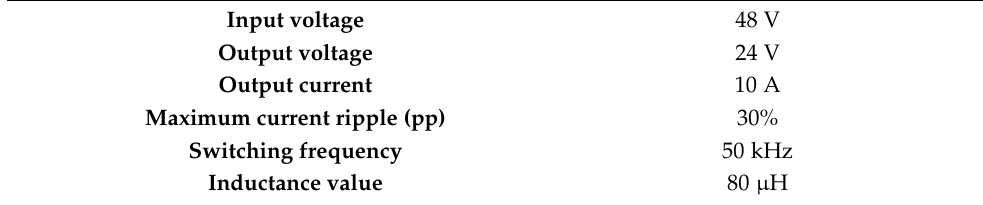
Table 1. Design specifications of the test case